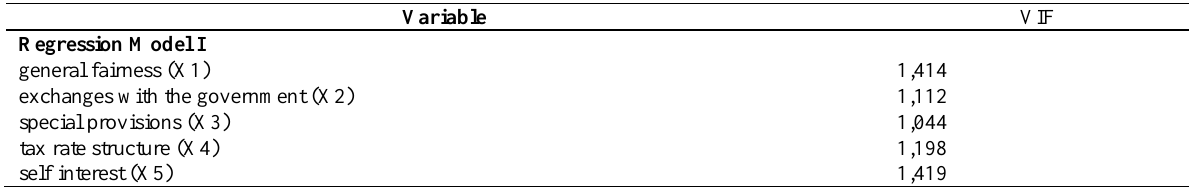
Table 3: Multicollinearity Test Results